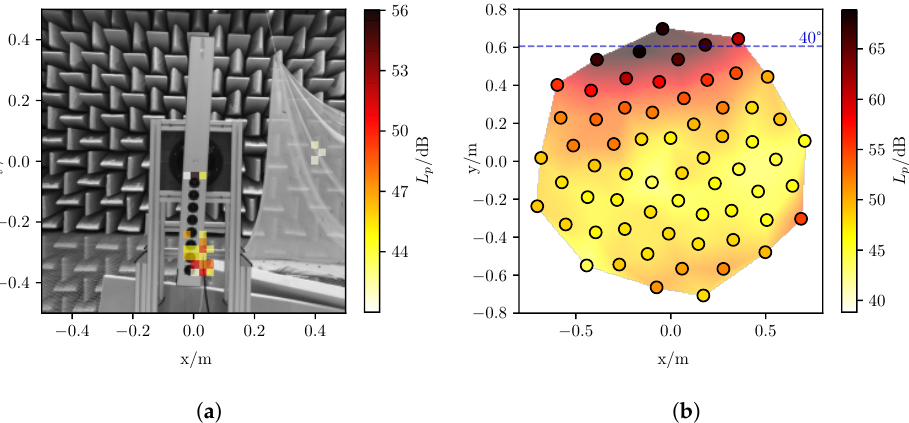
Figure 8. Test case 5 with a rotating speaker array and 40 ◦ positive direction steering: ( a ) source distribution; ( b ) source directivity in the direction of the microphones at the 5 kHz octave band. The blue dotted line indicates the theoretical maximum at 40 ◦ .